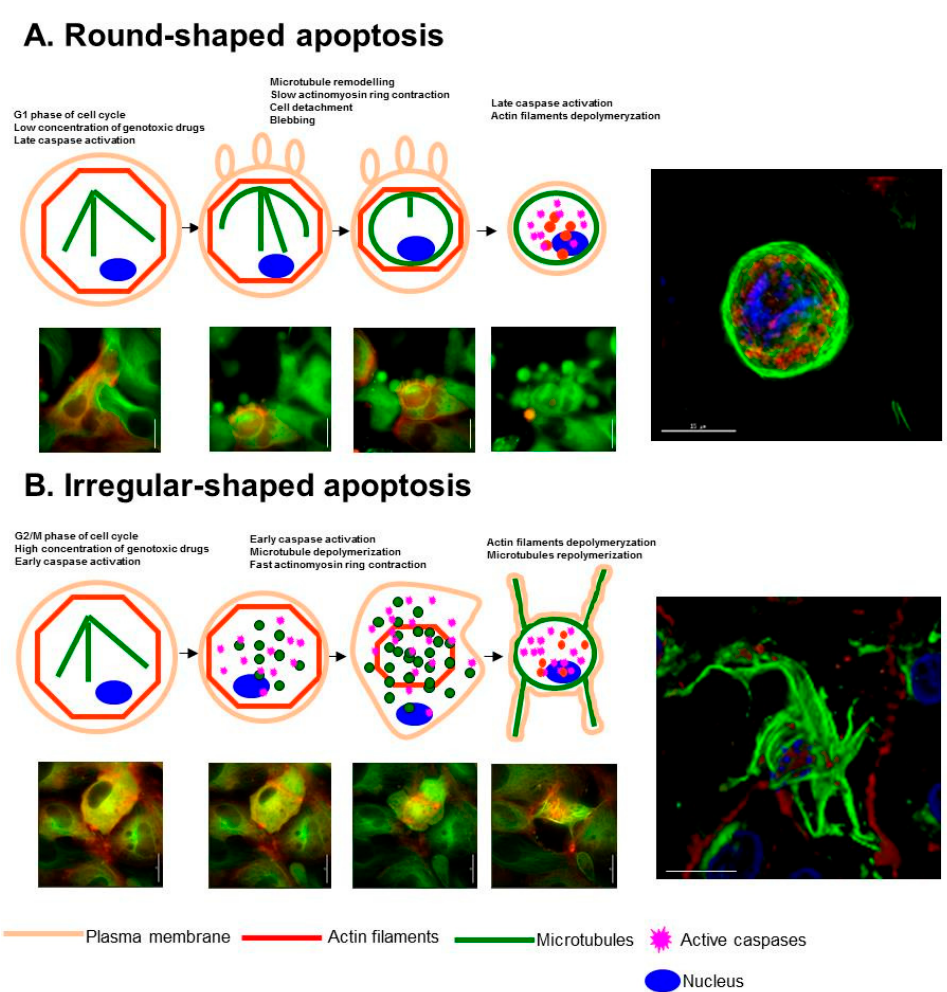
Figure 1. Schematic representation of the reorganization of actin filaments and microtubules during round ( A ) and irregular ( B ) -shaped apoptosis. Brown = plasma membrane; Blue = nucleus; Green = microtubules; Red = actin filaments; Pink = active caspases. Representative sequential images of round and irregular-shaped apoptosis in LLCPK-1 α cells expressing GFP- α tubulin and pdsRed-monomer-actin are also included. Apoptosis was induced by camptothecin treatment. Right panels, immunofluorescence microscopy of round and irregular H460 apoptotic cells. Green = anti- α -tubulin: Red = anti-actin; Blue = Hoechst staining for nuclei. Scale bar= 15 µ m.